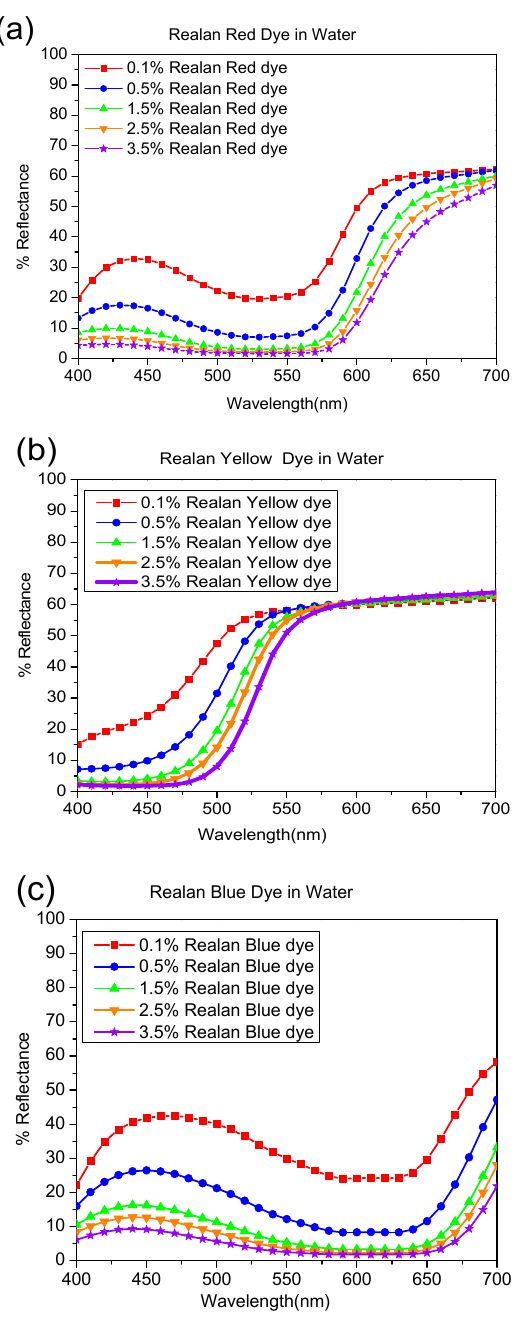
Figure 3. Percentage of reflectance value vs. wavelength (nm) of wool fibers dyed by ( a ) Realan Reactive Red, ( b ) Realan Reactive Yellow, and ( c ) Realan Reactive Blue in water.